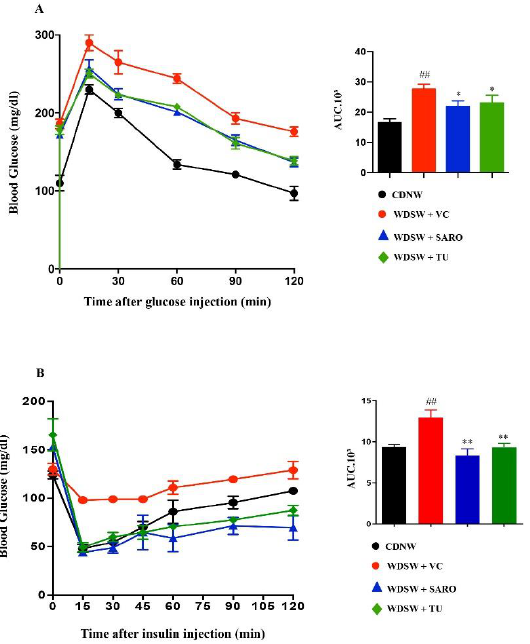
Figure 2. Tecomella undulata ( TU ) improves glucose tolerance and insulin sensitivity. CDNW and WDSW mice treated with vehicle control (VC), saroglitazar (SARO) or Tecomella undulata (TU) for 12 weeks. Mice were fasted overnight and blood glucose concentration (mg/dl) was measured after intraperitoneal injection of 1 g/kg glucose ( A ). Mice fasted for 4 – 5 h were administered 0.75 units/kg insulin and blood glucose concentration (mg/dL) measured ( B ). The bar graphs depict the area under the curve (AUC) with or without treatment. Data are expressed as mean with SEM for 8 – 10 mice per group. ## p < 0.001 compared to CDNW; ** p < 0.001 or * p < 0.05 compared to WDSW, vehicle control.